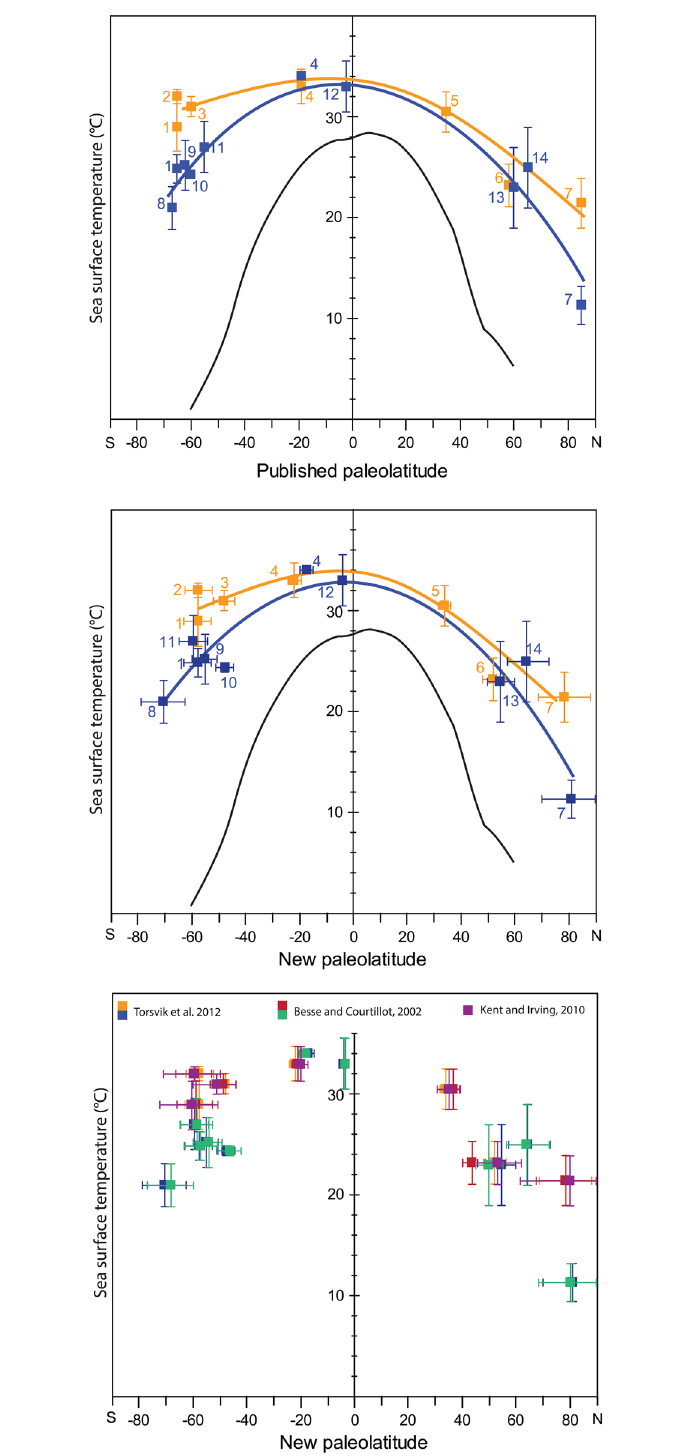
Fig 5. Latitudinal sea surface temperature (SST) gradients for the early- (orange) and middle (blue) Eocene (modified from Bijl and colleagues [2]). See text for full derivation of data. TEX 86 -derived SSTs (squares) were recalibrated to TEX 86 -H following Kim and colleagues [94]. (A) with paleolatitudes as published by Bijl and colleagues [2] and references therein, (B) with paleolatitudes and error bars using the paleolatitude calculator provided with this paper (www.paleolatitude.org), in the default reference frame